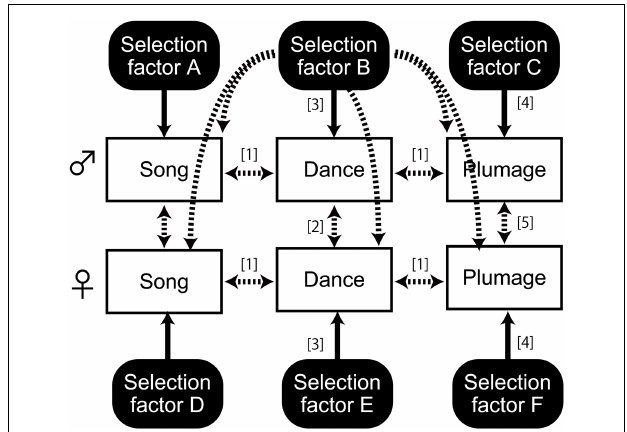
FIGURE 1 | Schematic view of the possible evolution of three sexual signals in males and females under multiple selection pressures. One-headed arrows show selection as exerted by an ecological/life history trait, and two-headed arrows show correlated responses. Solid and dashed lines show known or potential effects respectively. For illustrative purposes, the multimodal effects of particular selection pressures are only emphasized for a single factor (Selection factor B). Similar mechanisms may also apply to the other